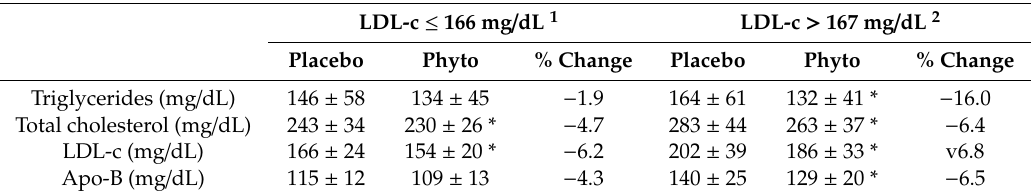
Table 4. Plasma lipids and apo B concentration according to the mean of LDL-c plasma concentration at baseline, of moderately hypercholesterolemic